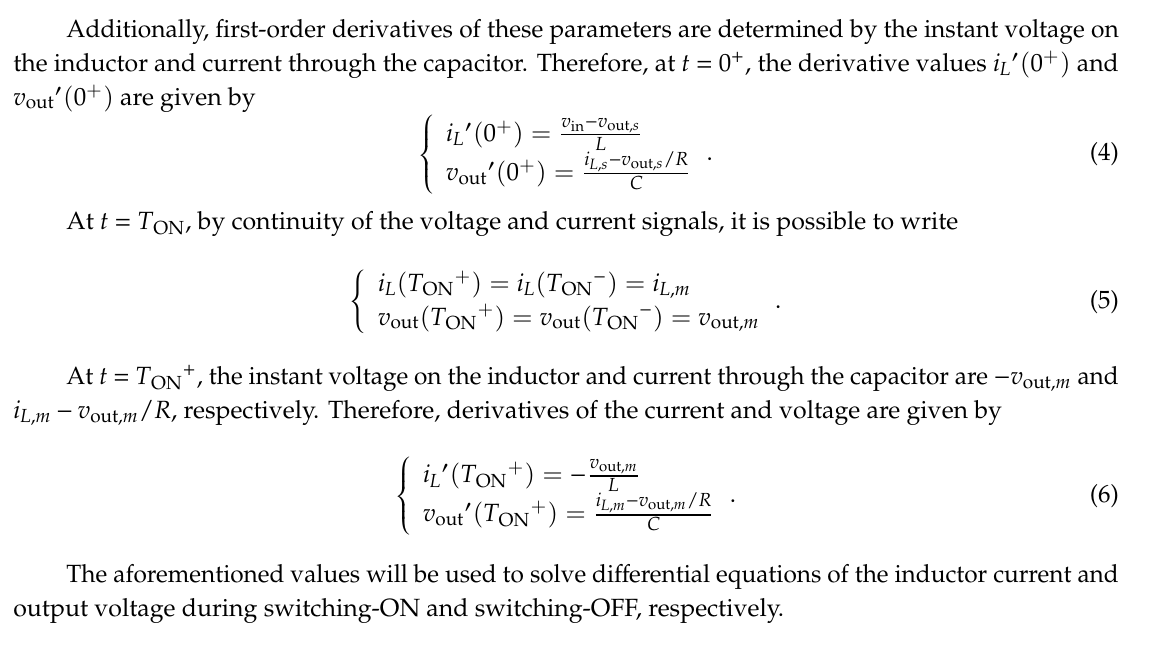
Figure 2. State variables and their derivative values at switching transients: ( a ) Inductor current, ( b ) derivative of inductor current, ( c ) output voltage, and ( d ) derivative of output voltage.